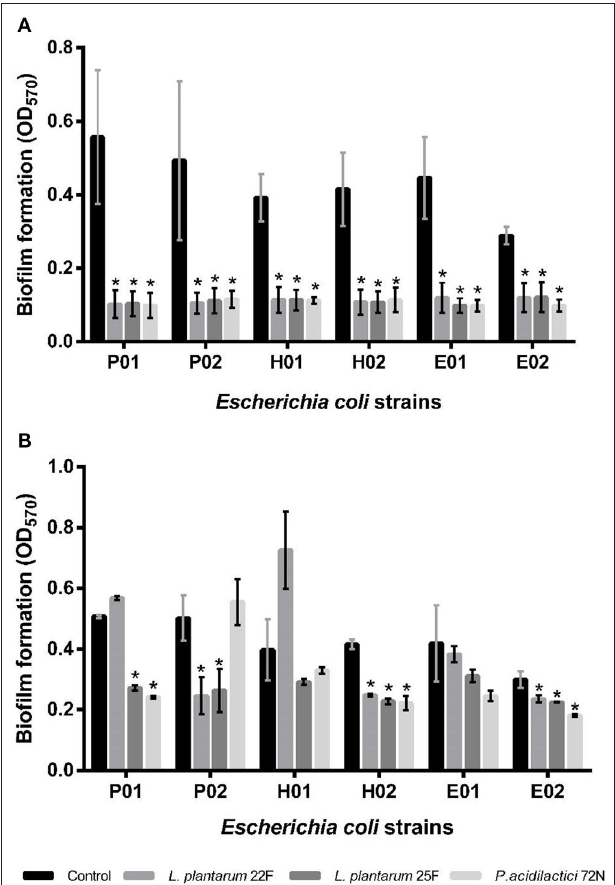
FIGURE 2 | Effects of non-neutralizing CFS (A) and neutralizing CFS (B) of LAB on biofilm of E . coli evaluated by crystal violet assay. A significant difference (* P < 0.05) was calculated by an independent t -test when compared with the control group.